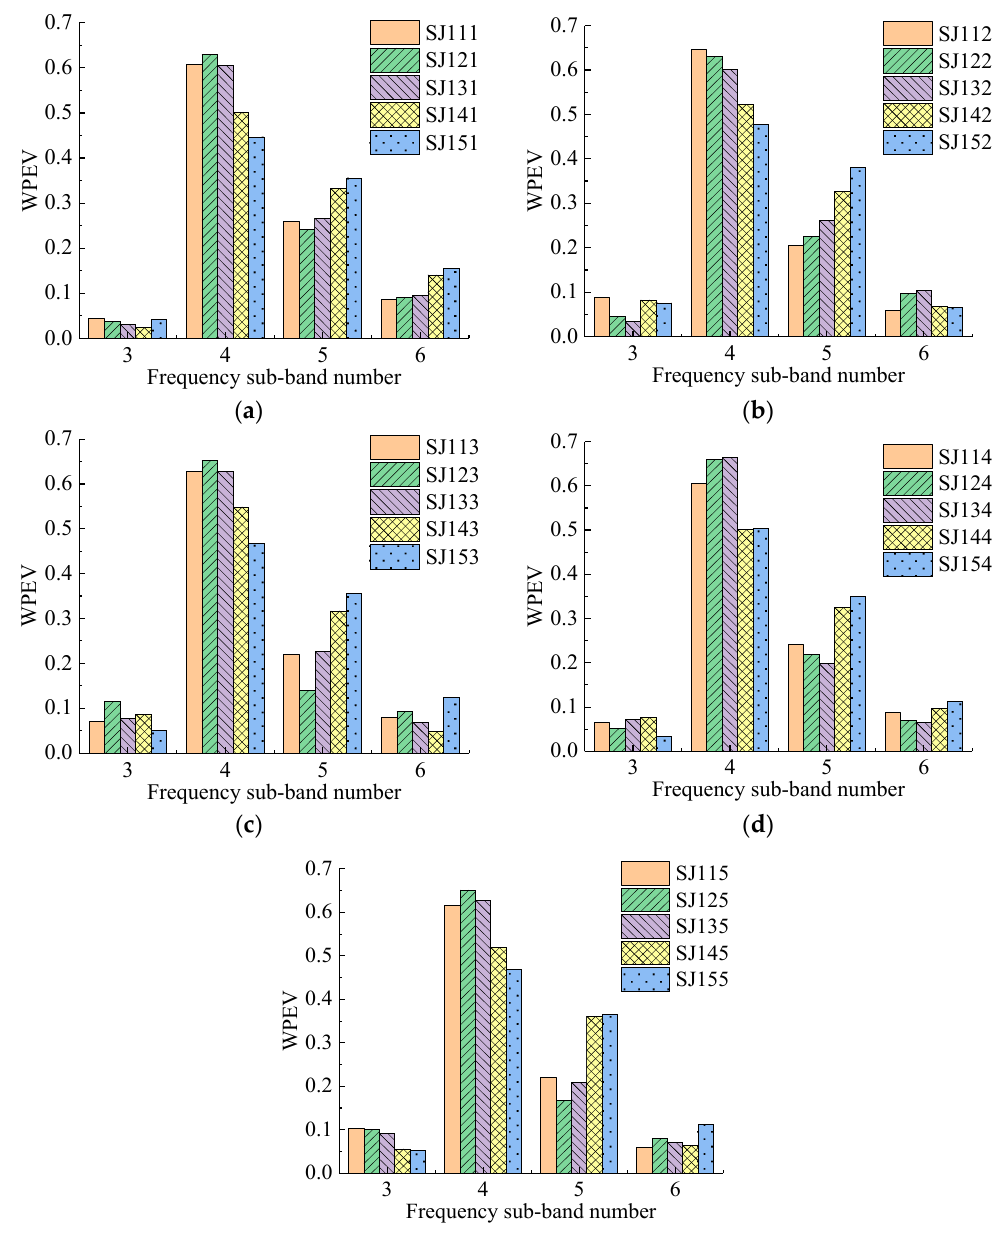
Figure 6. The wavelet packet energy vectors (WPEVs) of different detecting points of SJ1 group. ( a )